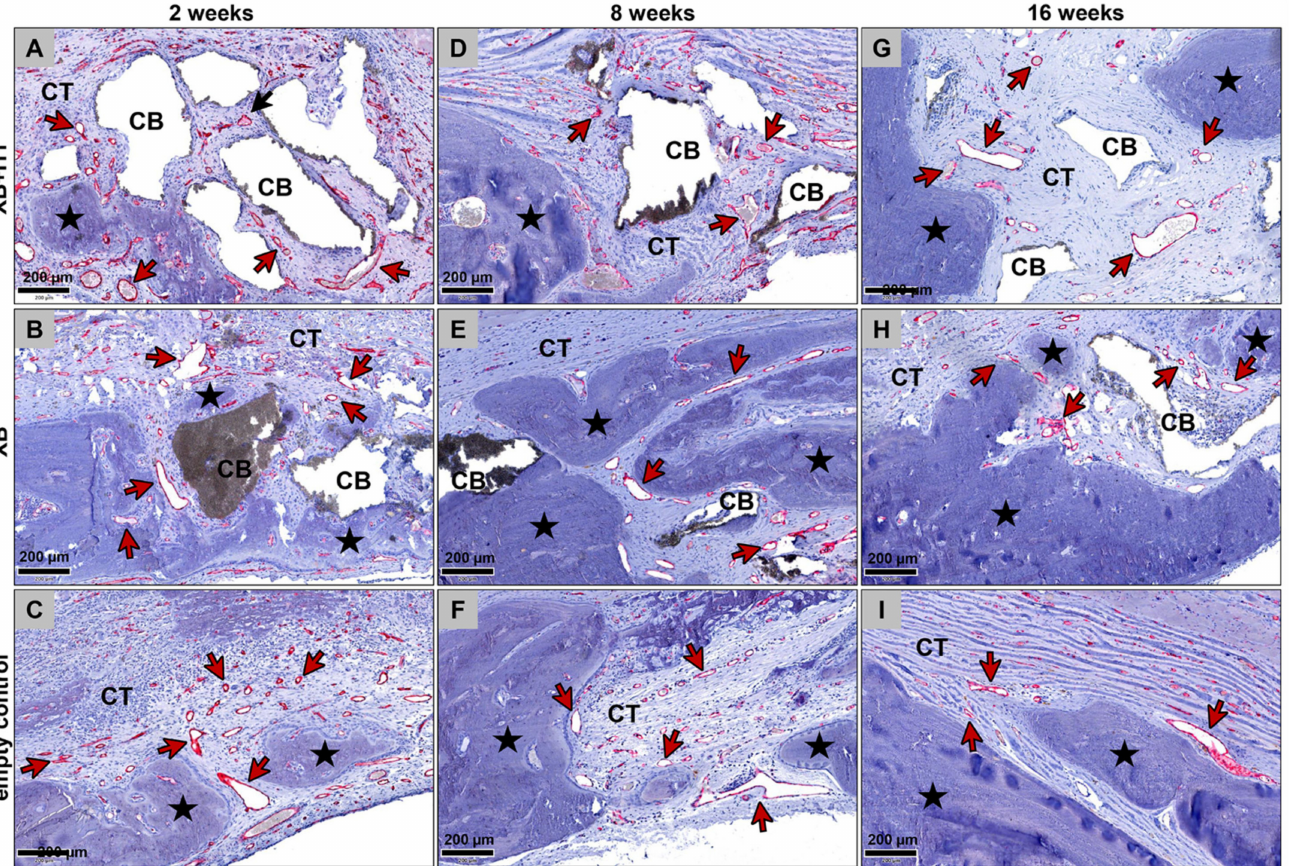
Figure 5. Representative overview of the vascularization pattern of the different study groups based on immunohisto- chemical detection of the CD31 expression at 2 weeks ( A–C ), 8 weeks ( D–F ), and 16 weeks ( G–I ) post implantationem. Red arrows = blood vessels, black asterisk = newly formed bone, CB = granules of the xenogeneic BSM, CT = connective tissue (CD31-immunostainings, 200 × magnification, scalebars = 200 µ